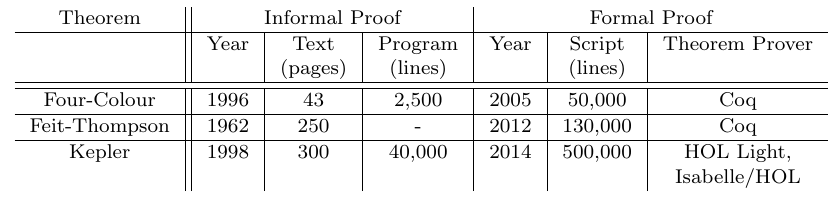
Table I. The three formalisations and the informal proofs they are based upon. Program and script lines refer to the number of non-comment, non-blank